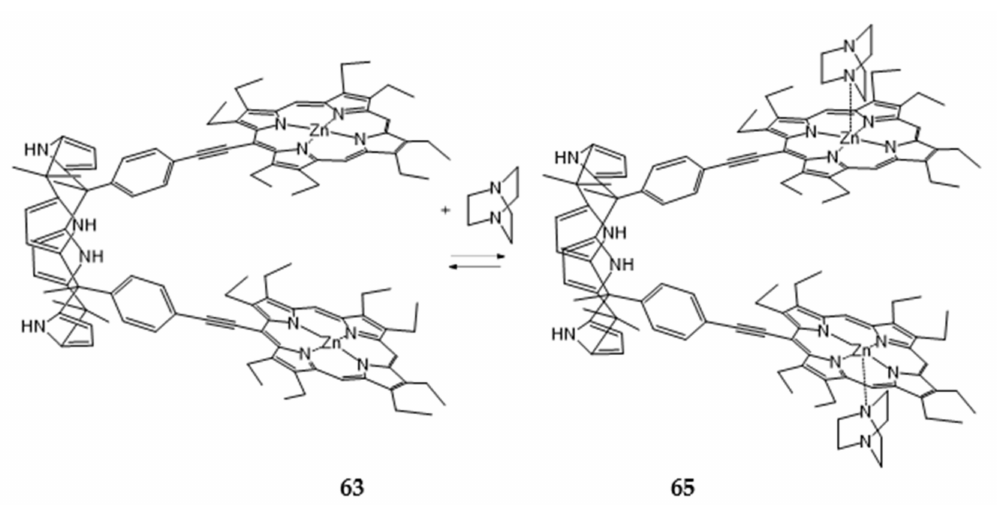
Figure 9. 1 H-NMR spectra of receptor 63 ( a ) and complex with fluorine 64 , ( b ) in CDCl 3 (300 MHz, 298 K) [67].